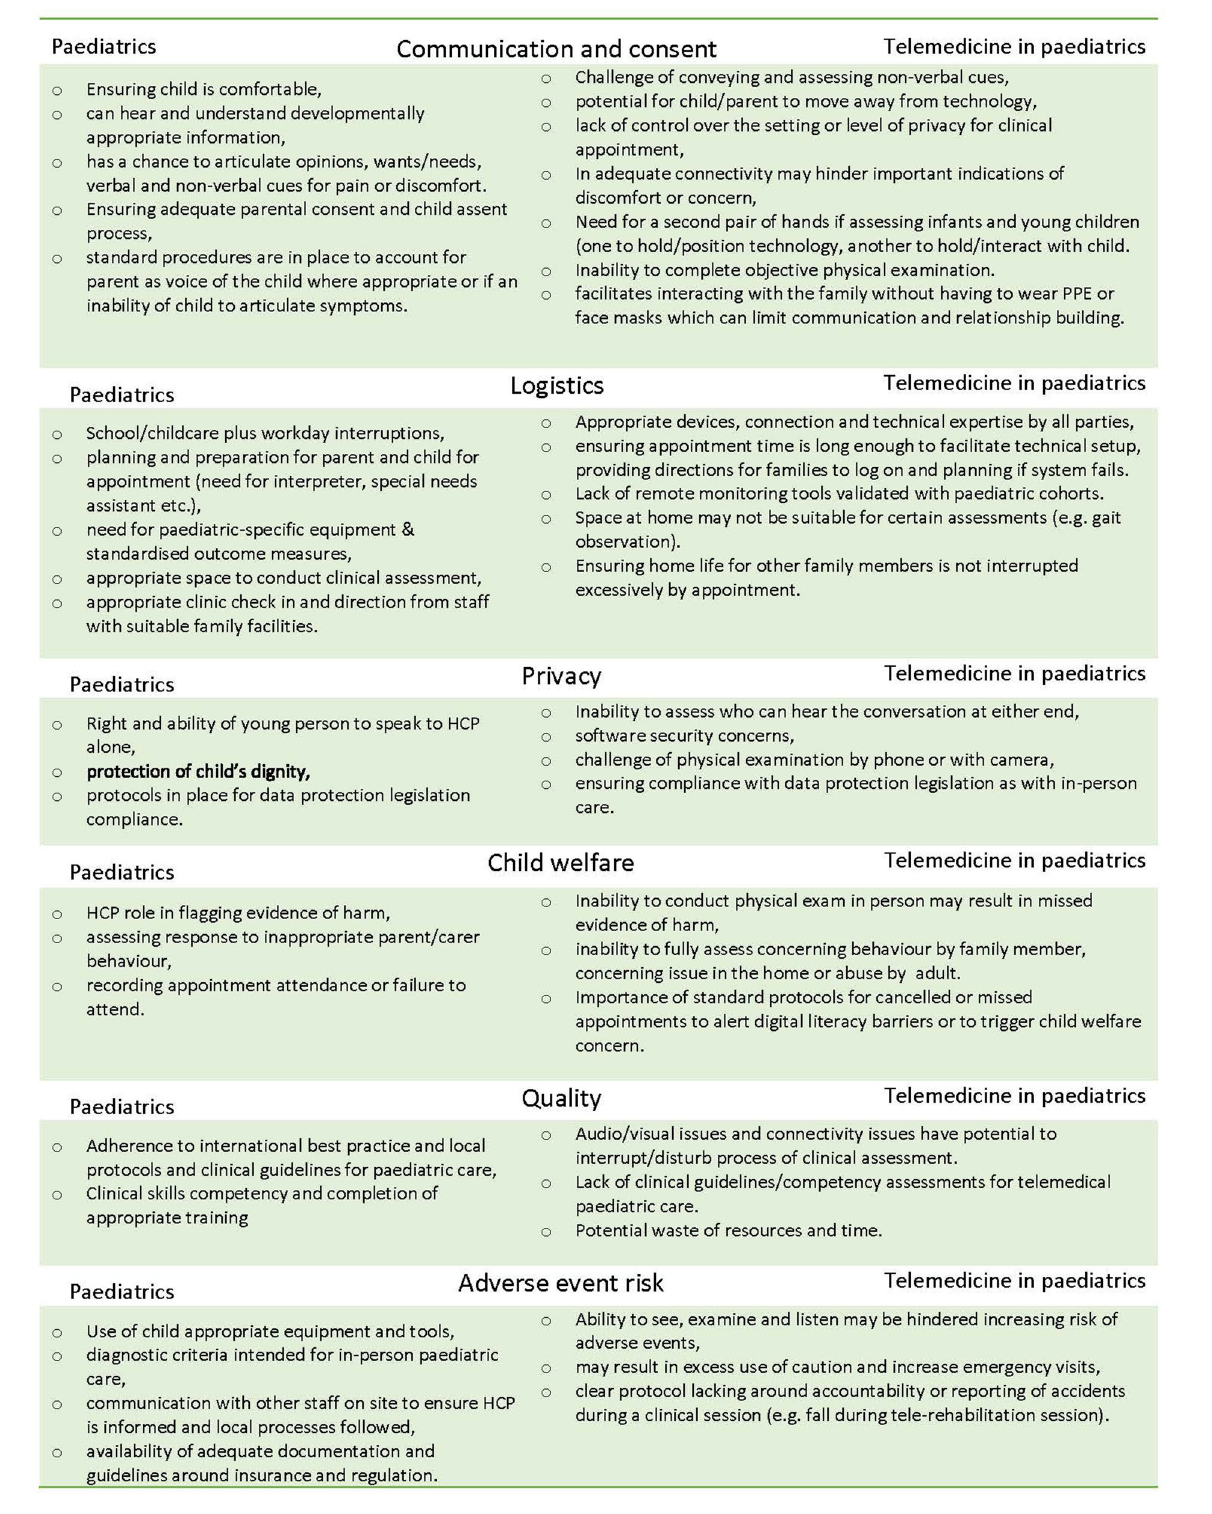
FIGURE 1 | Special considerations for extending telemedicine to paediatric care.